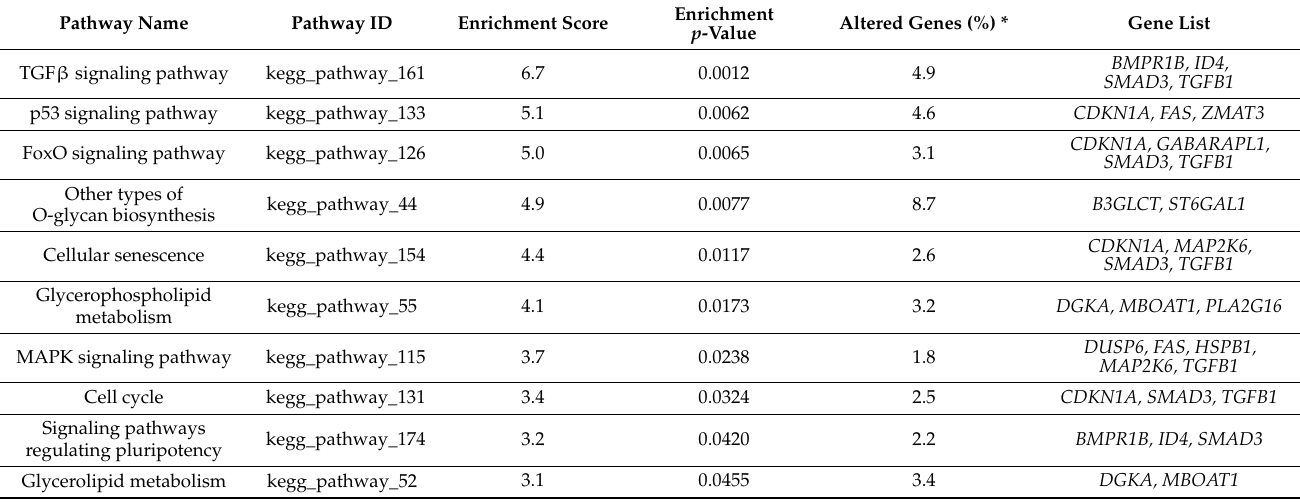
Table 2. Enrichment analysis of pathways for upregulated genes in vitrified